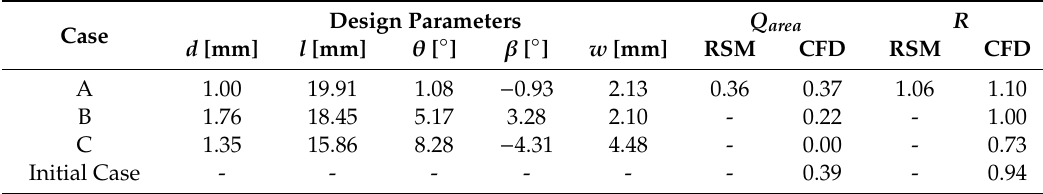
Table 4. Comparison of the selected scheme and the initial scheme.